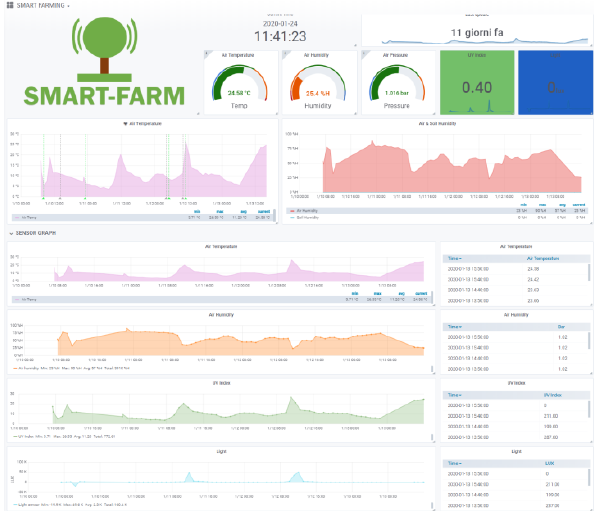
Figure 7. Grafana visualization panel for Smart-Farm app